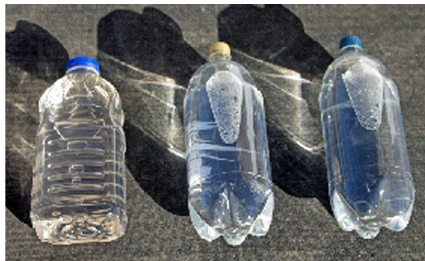
Table 3 Water analysis parameters for combined turbid water treatment samples